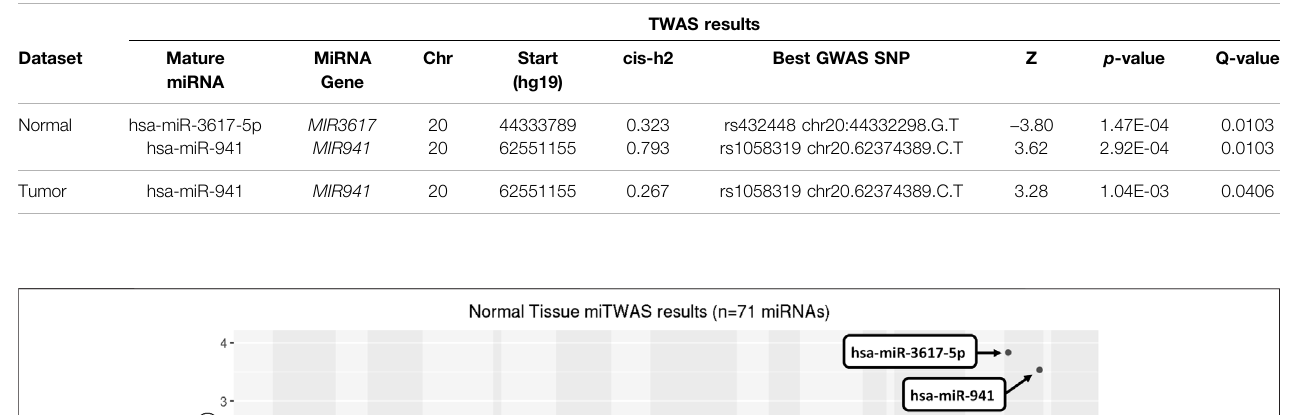
TABLE 2 | MiTWAS results for miRNAs identi fi ed as signi fi cant (FDR < 0.05) in at least one miRNA expression dataset.